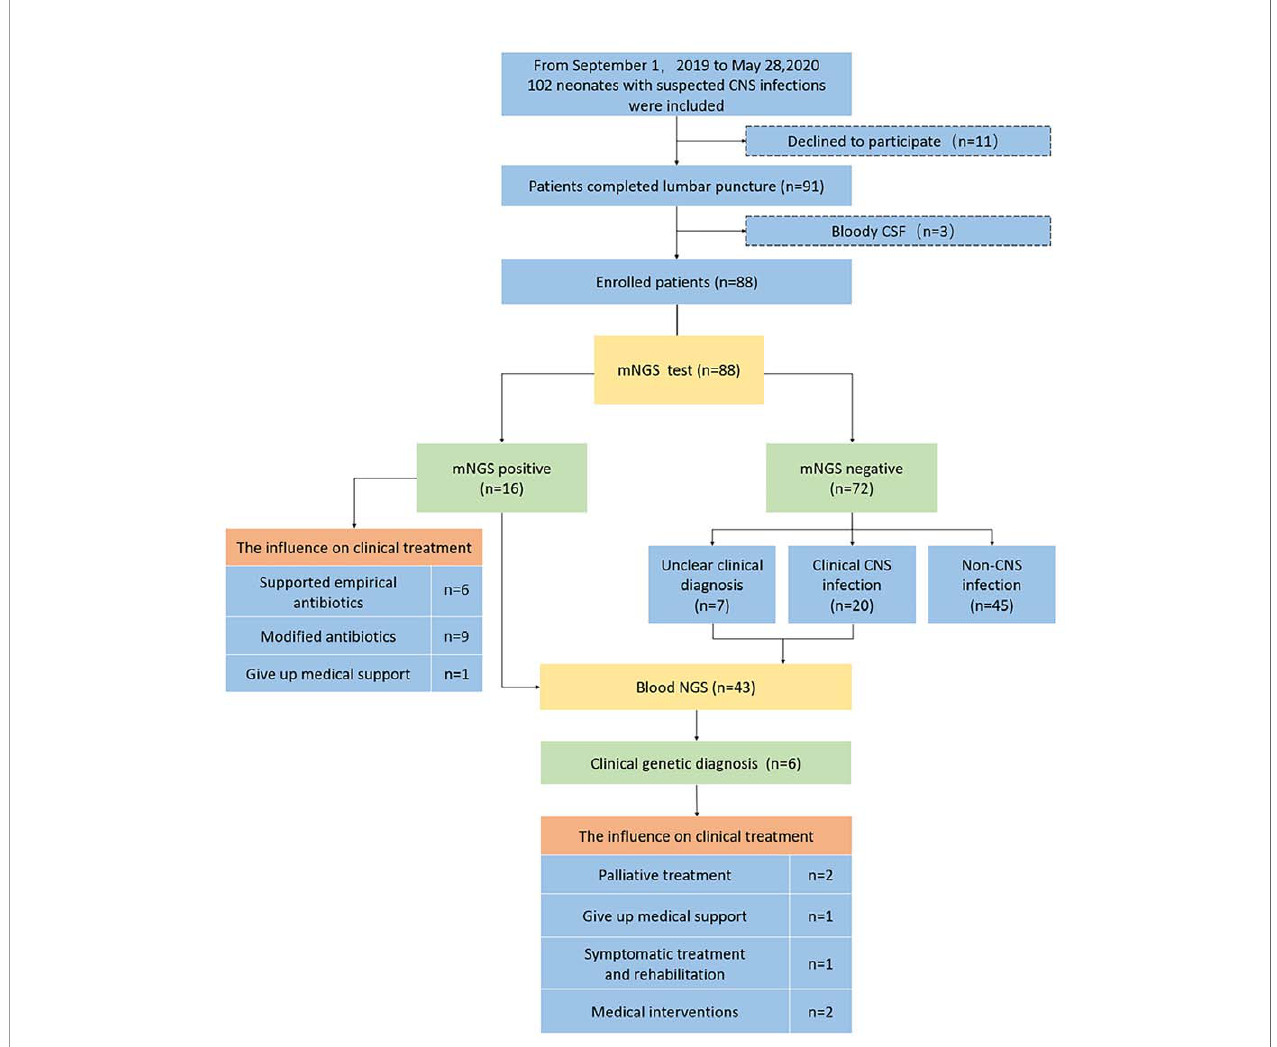
FIGURE 1 | Flowchart of the study. CNS central nervous system, mNGS metagenomic next-generation sequencing, NGS next-generation sequencing, CSF cerebrospinal fl uid. Non-CNS infection included neonatal sepsis/clinical sepsis, pneumonia, urinary tract infections, hypoxic ischemic encephalopathy, hydrocephalus, and intracranial hemorrhage with signs of infection. Unclear clinical diagnosis included encephalopathy with signs of infection. CSF pleocytosis was de fi ned as a CSF white blood cells (WBC) count ≥ 20/mm 3 (0 – 28 days of age) or >5/mm 3 (older children). De fi nite meningitis was de fi ned as (1) the presence of a pathogen in the CSF or (2) CSF pleocytosis with either a relevant pathogen present in the blood or an alternative positive diagnostic test. Probable meningitis was de fi ned as CSF pleocytosis with a relevant pathogen detected at a sterile site (except blood) and a discharge diagnosis of meningitis. Aseptic meningitis of unknown etiology was de fi ned as CSF pleocytosis without a pathogen identi fi ed. Possible meningitis was de fi ned as meningitis as the discharge diagnosis without microbiological con fi rmation. In this study, the etiologic diagnosis was de fi nite meningitis, and the clinical diagnosis included probable meningitis, aseptic meningitis of unknown an etiology and possible